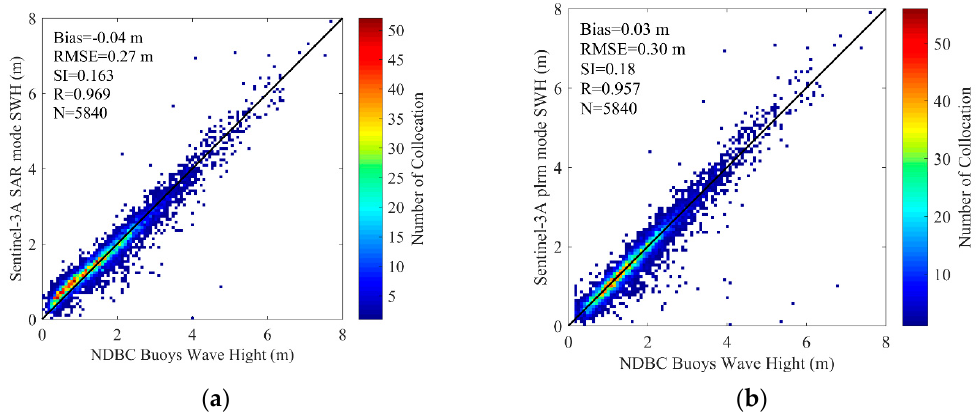
Figure 9. Scatterplots for the SWH comparisons between Sentinel-3A ( a ) SAR and ( b ) PLRM modes and NDBC buoys.